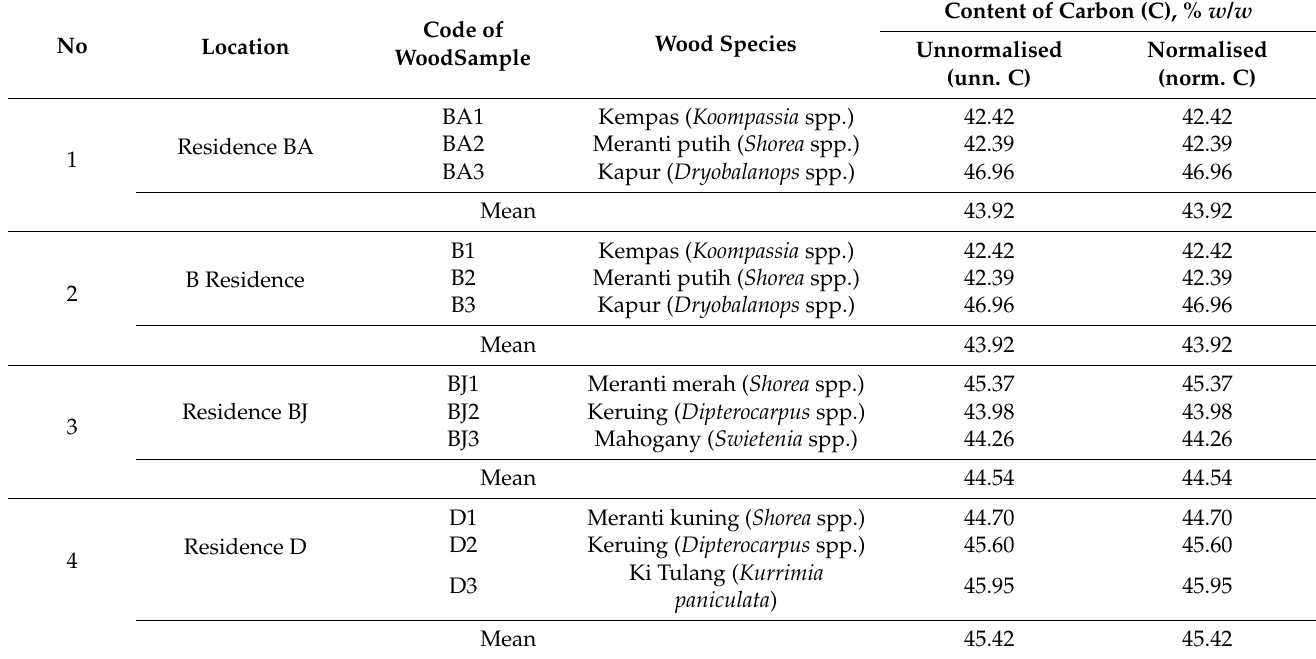
Table 5. Proportions of carbon in the wood used in